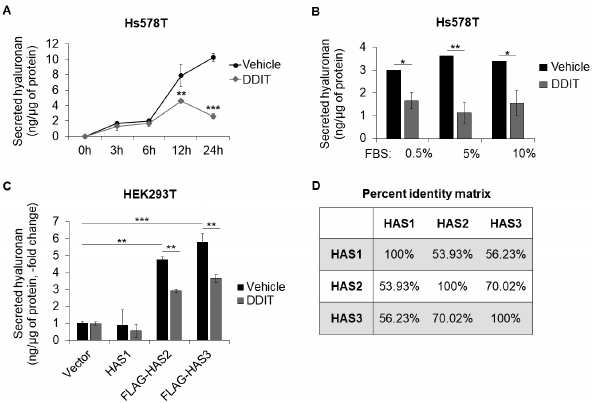
Figure 4. Effect of DDIT on hyaluronan synthesis by different HAS isoforms. ( A ) Hyaluronan secreted by Hs578T breast cancer cells after treatment with vehicle (0.04% DMSO) or DDIT (80 µ M) in serum-free medium for 3, 6, 12 and 24 h. ( B ) Hyaluronan secreted after incubation with vehicle or DDIT in culture medium with serum (0.5, 5 or 10% FBS), for 24 h. ( C ) Hyaluronan secreted by HEK293T cells after overexpression of HAS1, FLAG-HAS2 or FLAG-HAS3 and incubation with vehicle or DDIT. ( D ) Comparison of amino acid sequence. Statistical significance is depicted as asterisks (*, p < 0.05; **, p < 0.01; ***, p < 0.001).